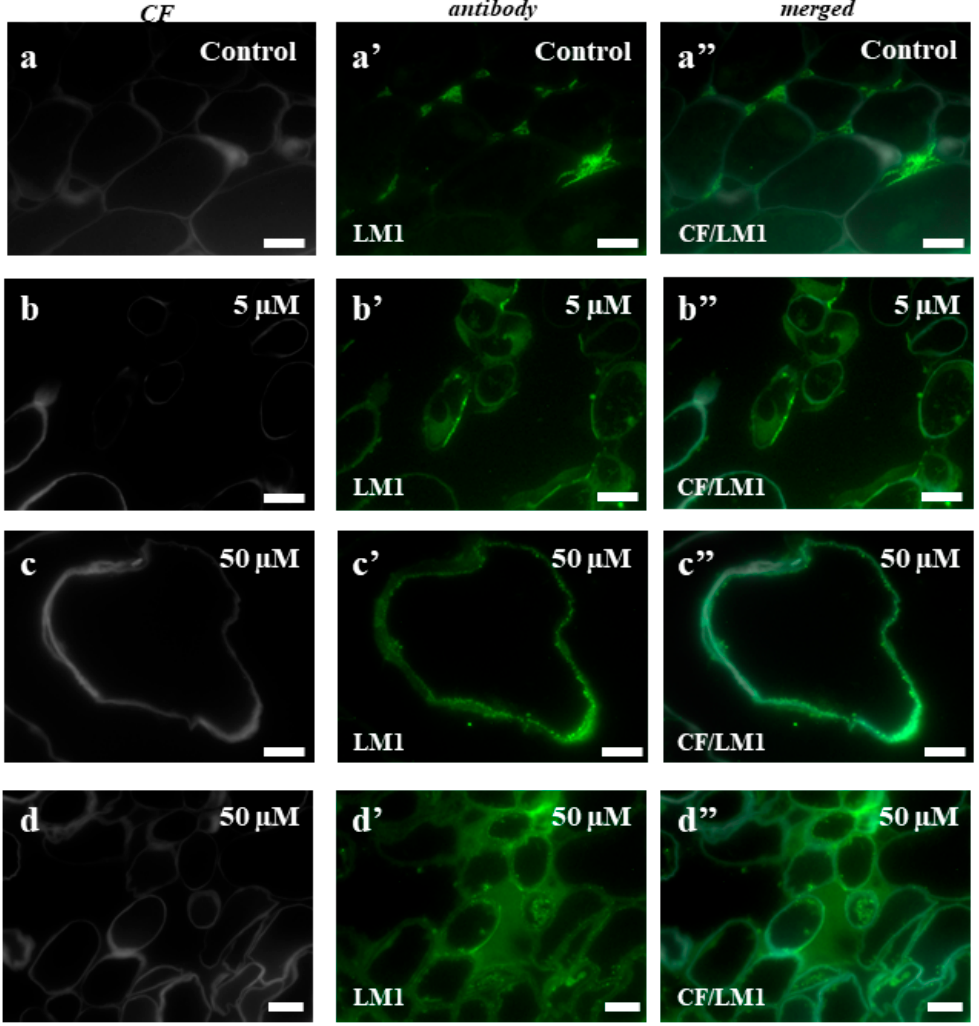
Figure 7. Immunolocalization of LM1 in the Brachypodium callus. ( a – a” ): control callus. ( b – b” ): callus that has been treated with 5 µM of 5-azaC. ( c – c” ), ( d – d” ): callus that has been treated with 50 µM of 5-azaC. The greenish background on these photomicrographs is due to the autofluorescence. Scale bars, 10 µm.